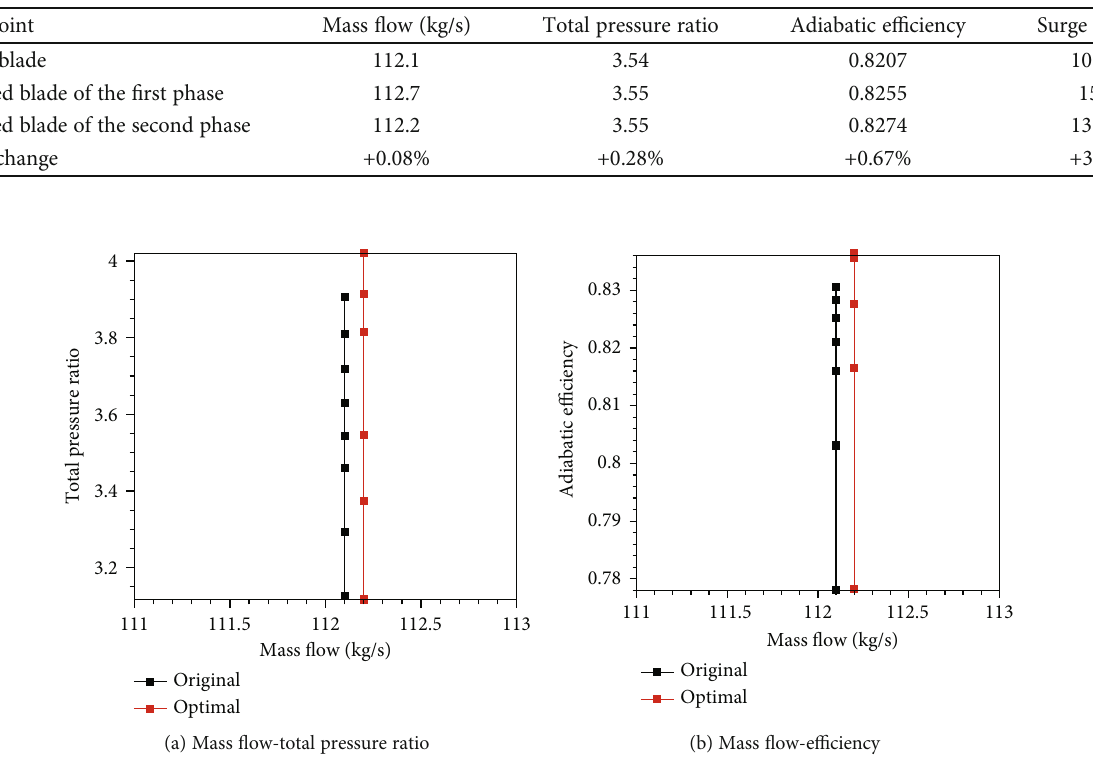
Figure 13: Comparison of the performance between the optimized blade and original blade in the second